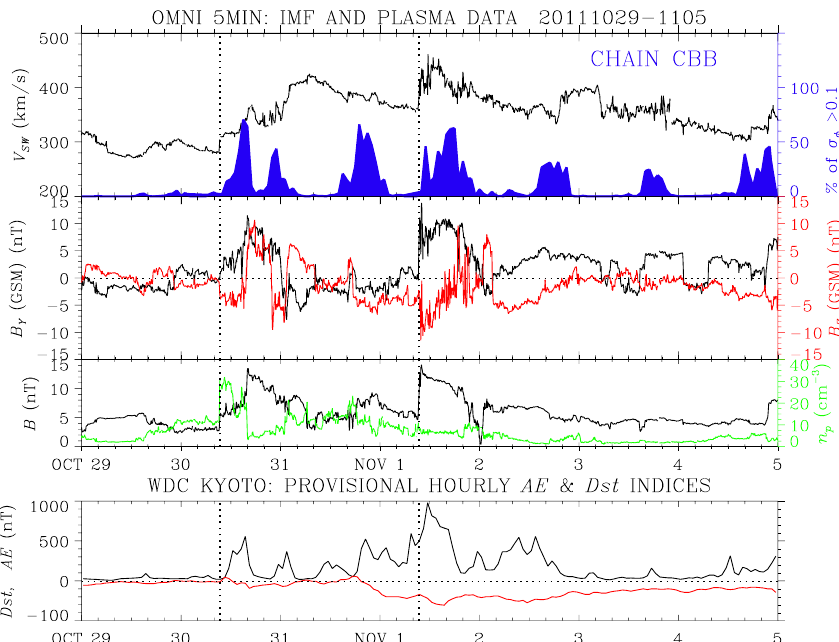
Fig. 2. Solar wind magnetic field and plasma parameters from OMNIWeb dataset. Hourly occurrence of σ 8 > 0 . 1 radians from Cambridge Bay is highlighted in blue. Hourly values of AE (black line) and Dst (red line) indices are shown in the bottom